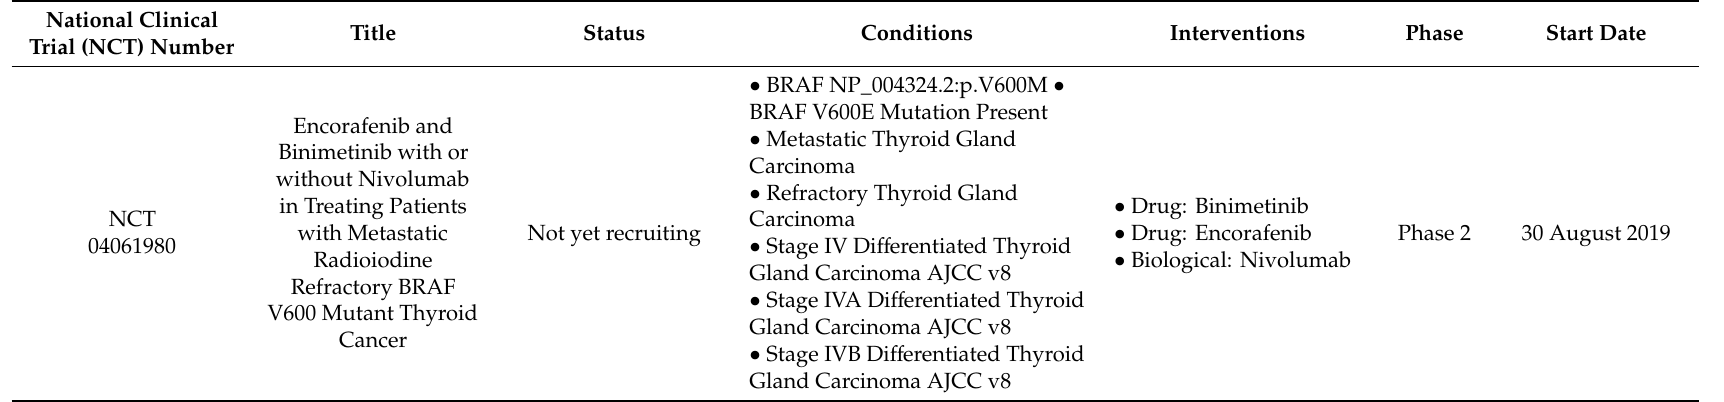
Table 10. Clinical trials investigating combined MAPK pathway-targeted therapy and immunotherapy in patients with thyroid